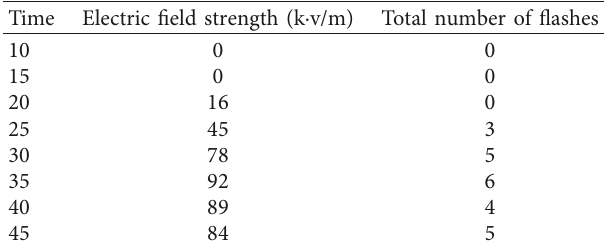
Table 5: Lightning electric field and changes in total number of